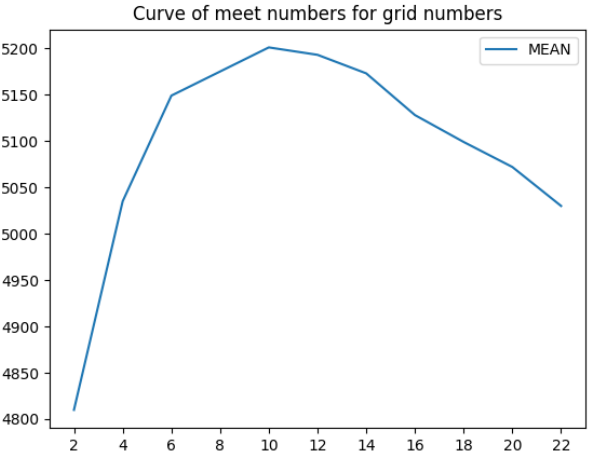
Table 2. Rainfall enhancement criteria for stratiform and cumulus mixed clouds.